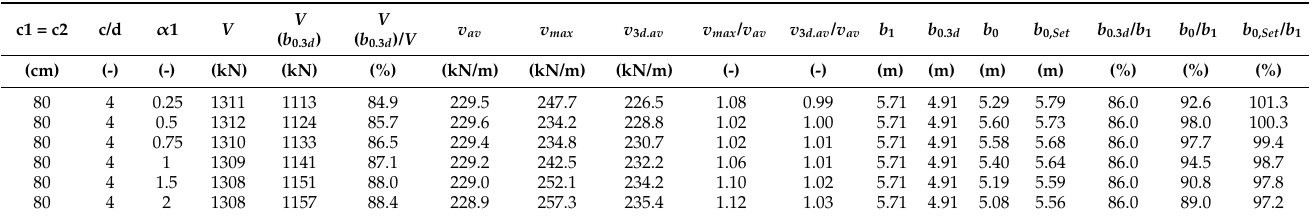
Table A2. Analysis of the shear force distribution in the control perimeter 2 d with 80 cm shear cap size.